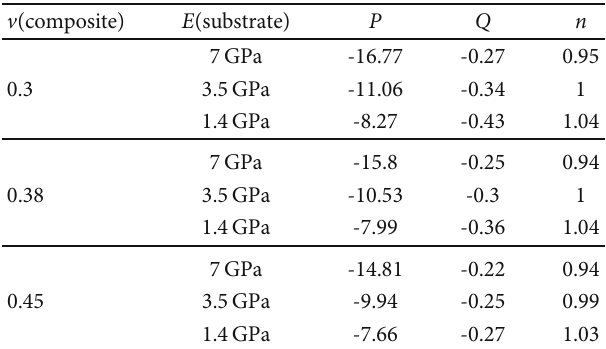
Figure 12: Fitting curves when v (composite) equals (a) 0.3, (b) 0.38, and (c) Table 2: Results of the fi tting parameters.